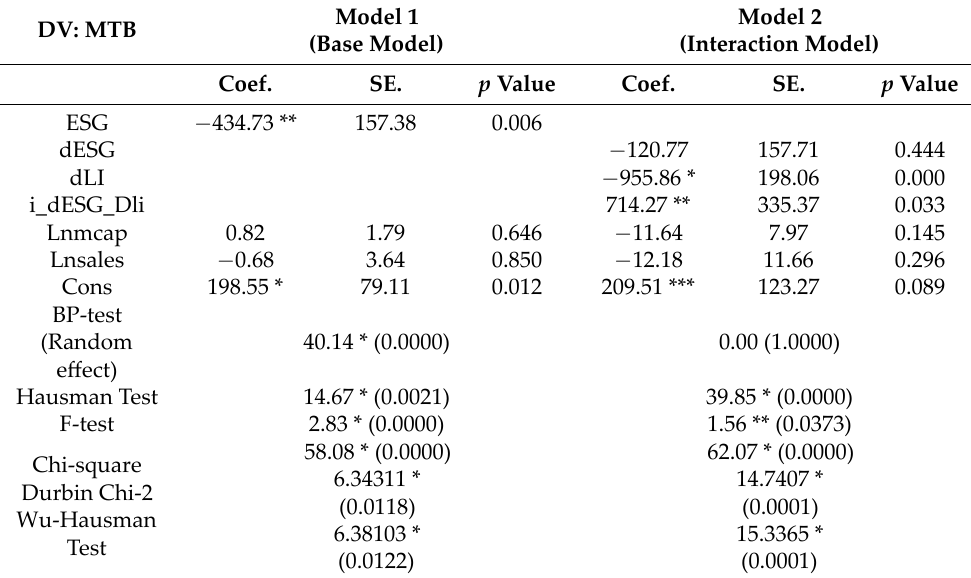
Table 4. Result of